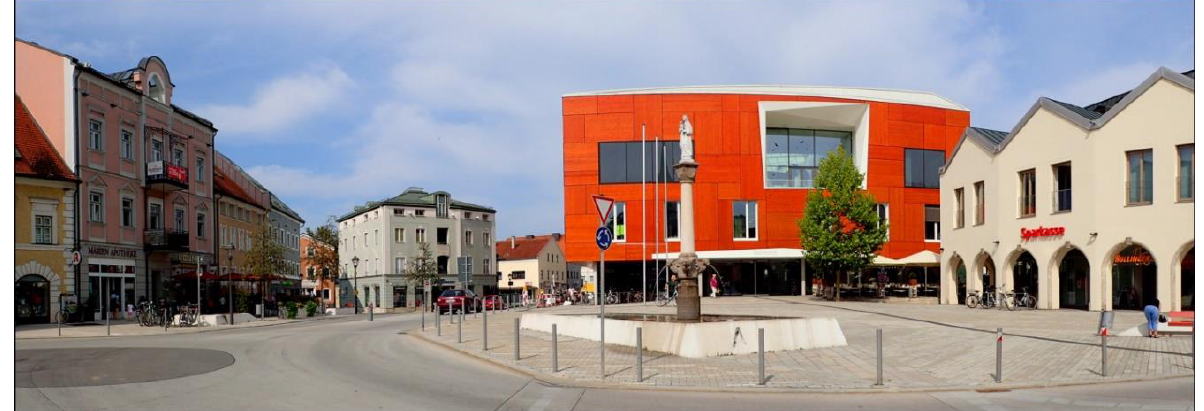
Figure 3. Bad Aibling - view of the main square in the historical old